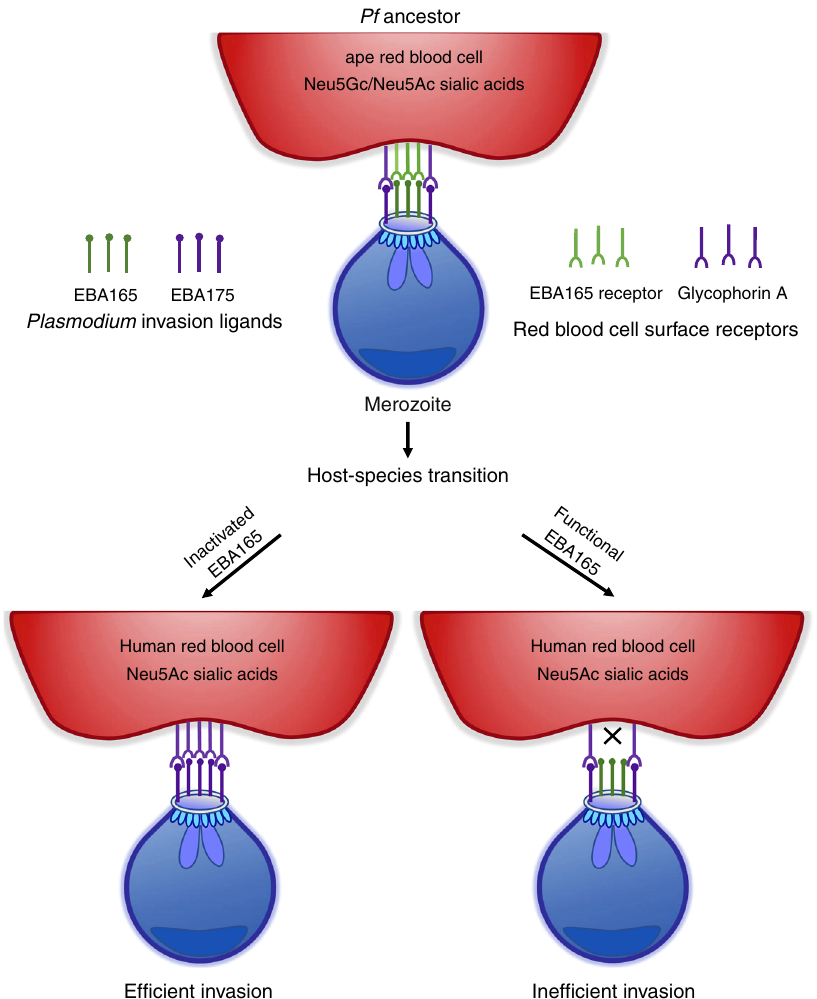
Fig. 6 PfEBA165 inactivation may have predisposed P. falciparum ancestor to invade human erythrocytes. Invasion ligands function in a partially redundant manner during erythrocyte recognition, and gene deletion studies suggest a de fi ned hierarchy of interactions. If EBA165, which only recognises ape-speci fi c sialic acids (Neu5Gc), was the dominant invasion ligand in the ancestor of P. falciparum , inactivation may have allowed PfEBA175, which is not Neu5Gc speci fi c, to play a more dominant role in invasion (left hand arrow). This would have either predisposed parasites to more effectively invade human erythrocytes, which only expresss Neu5Ac, or increased growth after host-species transition had occurred, selecting for strains where PfEBA165 was inactivated. By contrast ancestral parasites with a dominant and intact PfEBA165 would still primarily rely on Neu5Gc sialic acids for invasion, and hence would invade human erythrocytes less ef fi ciently, reducing the likelihood of species transition, or reducing growth rates once the transition had baits) were immobilised on streptavidin-coated 96-well plates by incubating at replated on MS-5 stroma on day 18 and harvested on day 20 or 21. Cells were saturating concentrations for 1h. Plates were washed three times in HBST and stored at 4°C in incomplete RPMI (RPMI-1640 [Sigma – Aldrich] supplemented normalised pentameric β -lactamase-tagged proteins (designated preys) were added with 25mM HEPES and 50mg l − 1 hypoxanthine) until binding and fl ow cyto- (100 μ l/well) and incubated for 1 h. Plates were washed with HBST then HBS, metry assays. before analysing the hydrolysis of nitroce fi n substrate (60 μ l at 125 μ gml − 1 ) by measuring absorbance at 485 nm. Flow cytometry detection of Neu5Gc and erythrocyte receptors . Neu5Gc and erythrocyte receptor surface expression was assessed by fl ow cytometry. Cells were Cultured red blood cells (cRBCs) . Neu5Gc was expressed on the surface of washed three times in PBS containing 0.5% Neu5Gc-free blocking agent (Siamab) and pelleted at 500 g for 4 min in 96-well plates at 5× 10 5 cells/well. Cells were modi fi ed human erythrocytes by expressing chimpanzee CMAH in ex-vivo- cultured red blood cells (cRBCs) 26 . Brie fl y, differentiation and proliferation of bone incubated with antibodies at the following dilutions: anti-Neu5Gc (1:5000, Sia- mab), phycoerythrin(PE)-conjugated anti-DARC (1:10, 130-105-683, Miltenyi marrow-derived CD34 + hematopoietic stem cells (Lonza) were achieved in Iscove ’ s Biotec), anti-CD71-PE (1:10, 130-104-151, Miltenyi Biotec), anti-BSG (1:1000, Modi fi ed Dulbecco-based medium (Biochrom) supplemented with 5% solvent/ Clone MEM-M6/6, Axxora [Exbio]), fl uorescein isothiocyanate-conjugated anti- detergent virus-inactivated human plasma (Octaplas, Octapharma), stem cell factor glycophorin A (GPA) (1:50, Clone 2B7, 60152FI, STEMCELL Technologies) and (R&D Systems), hydrocortisone (Invitrogen), IL-3 (R&D Systems), and ery- anti-glycophorin C (GPC)-FITC (1:500, BRIC 10, sc-59183 FITC,Santa Cruz). thropoietin (Amgen) according to a published protocol 48 with the following After 1 h incubation at room temperature and three washes in blocking buffer, modi fi cations. Cells were transduced on day 7 with lentivirus harbouring either the unstained cells and cells stained with DARC, CD71, GPA and GPC antibodies were chimpanzee ( Pan troglodytes ) CMAH cDNA sequence in pLVX-Puro (Clontech) resuspended in 100µl PBS for fl ow cytometry analysis (MACSQuant; Miltenyi or the empty vector, pLVX-Puro. The CMAH insert was codon-optimized for Biotec). Neu5Gc-stained cells were incubated in anti-chicken IgY-Alexa Fluor human expression and synthesized with a C-terminal tobacco etch virus (TEV) 488 secondary antibody (Life Technologies) at 1:1000 for 30 min at room tem- cleavage site and FLAG-c-myc tags (GeneArt). Transductants were selected on perature. Unstained control samples were incubated in anti-mouse IgG2a-PE (1:10, 2mg ml − 1 puromycin (Sigma – Aldrich). Drug selection was maintained until day Miltenyi Biotec), anti-chicken IgY-Alexa Fluor 488 antibody or anti-mouse 13 when cells were co-cultured on a murine MS-5 stromal cell layer. Cells were